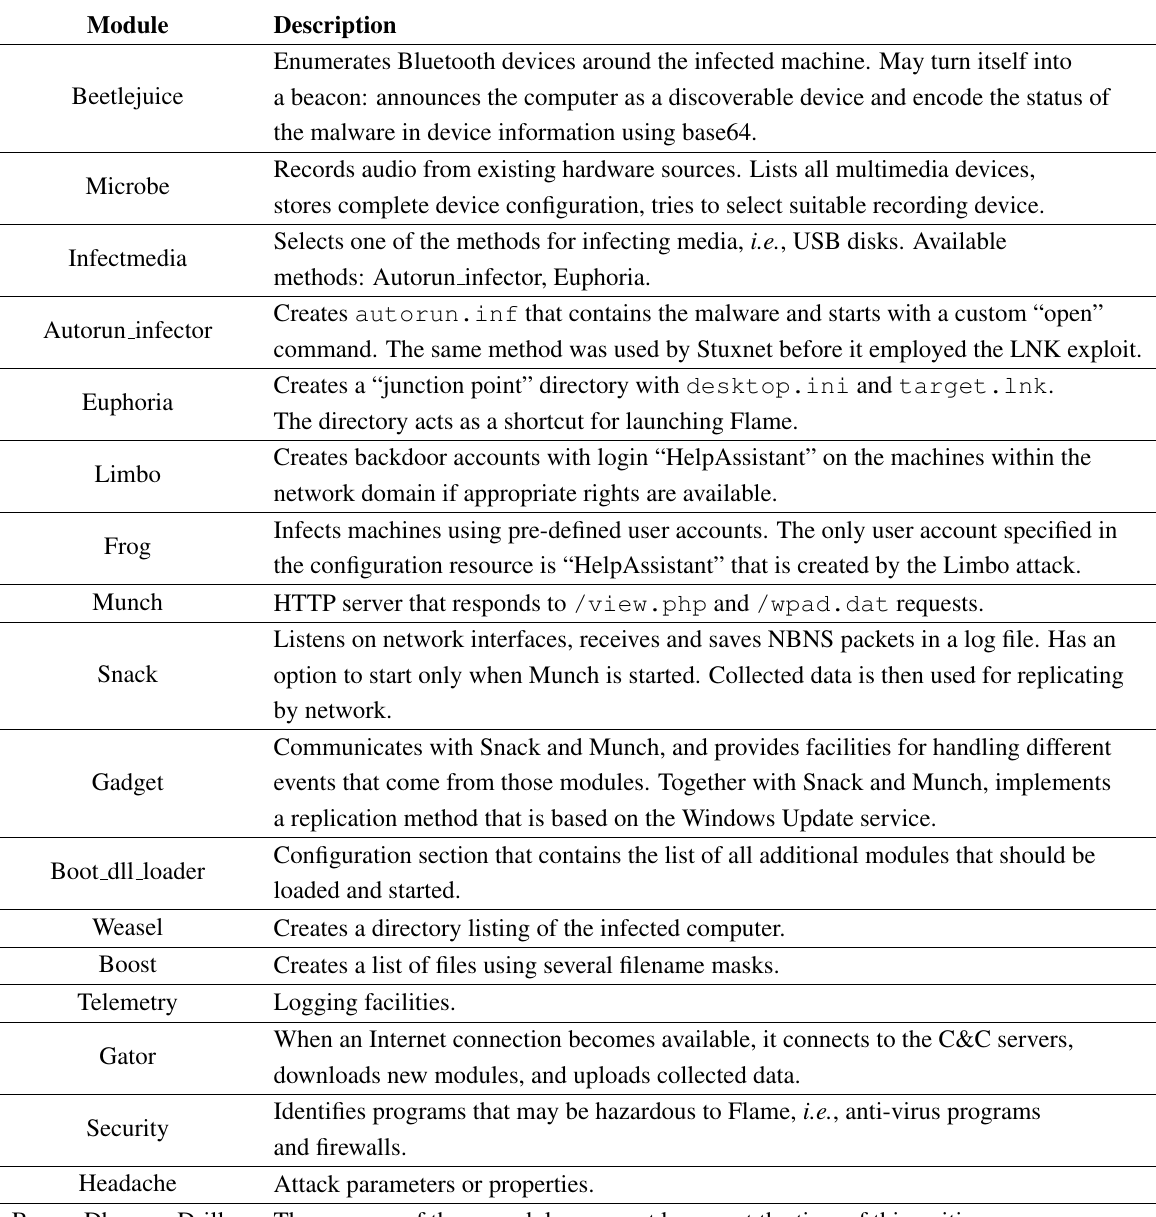
Table 1. The modules of Flame as described by researchers from Kaspersky